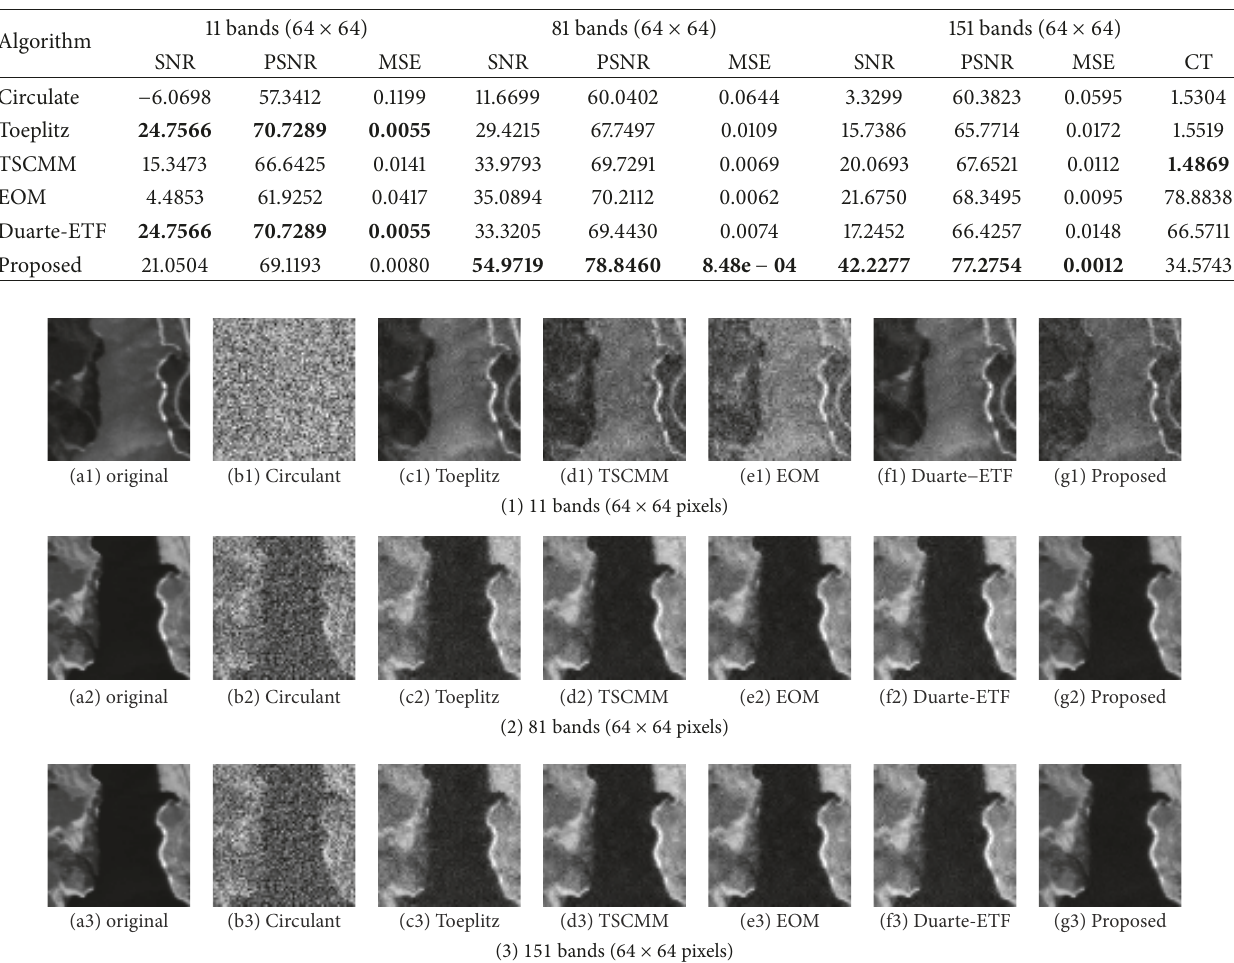
Table 3: The objective evaluations of different matrixes of recovery Jasper Ridge.